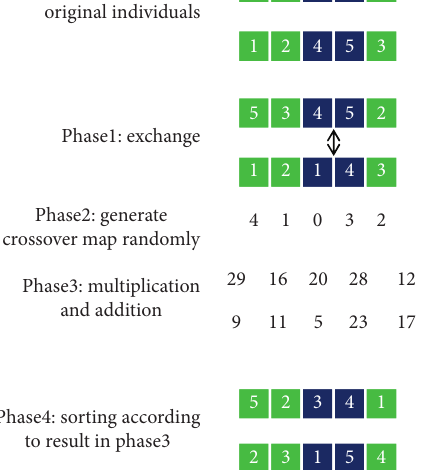
Figure 5: Procedure of tie-breaking